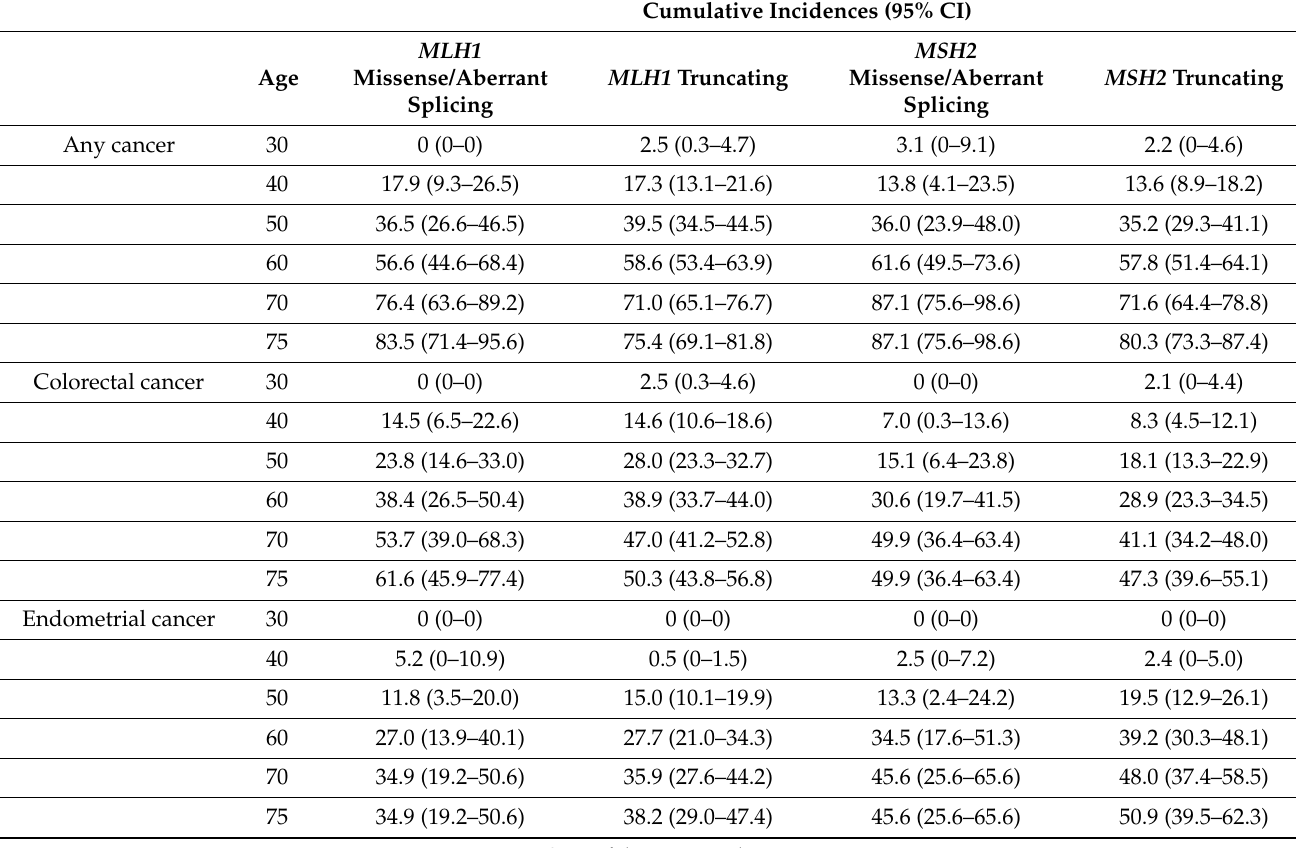
Table 2. Cumulative cancer incidences stratified by age, gene, variant, and organ.